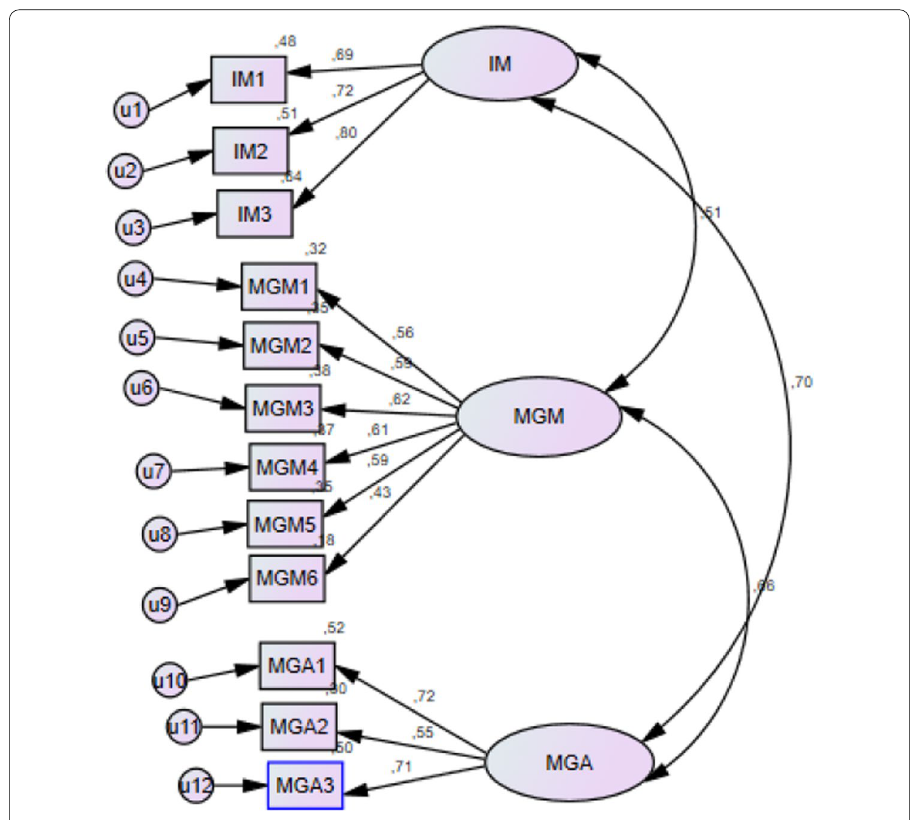
Fig. 8 Structural Equation Model